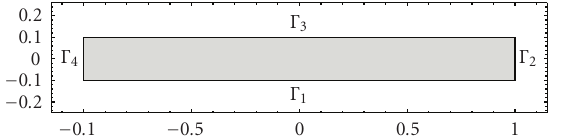
Figure 4: Geometry of the domain Ω = (cid:5)− 1,1 (cid:6)×(cid:5)− 0 . 1,0 . 1 (cid:6) . Here, we indicate the boundary parts of Ω by symbols Γ 1 , Γ 2 , Γ 3 , and Γ 4